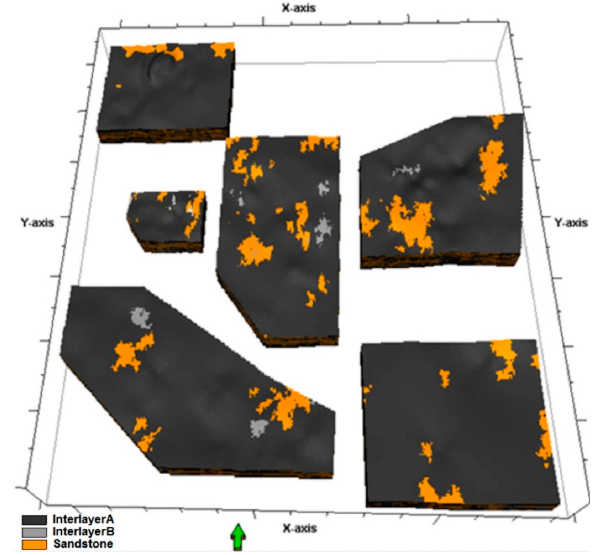
Figure 7. 3-D sandstone and mudstone distribution models for the six subdivided zones. It’s noted that each distribution model is just one of the equiprobable realizations.